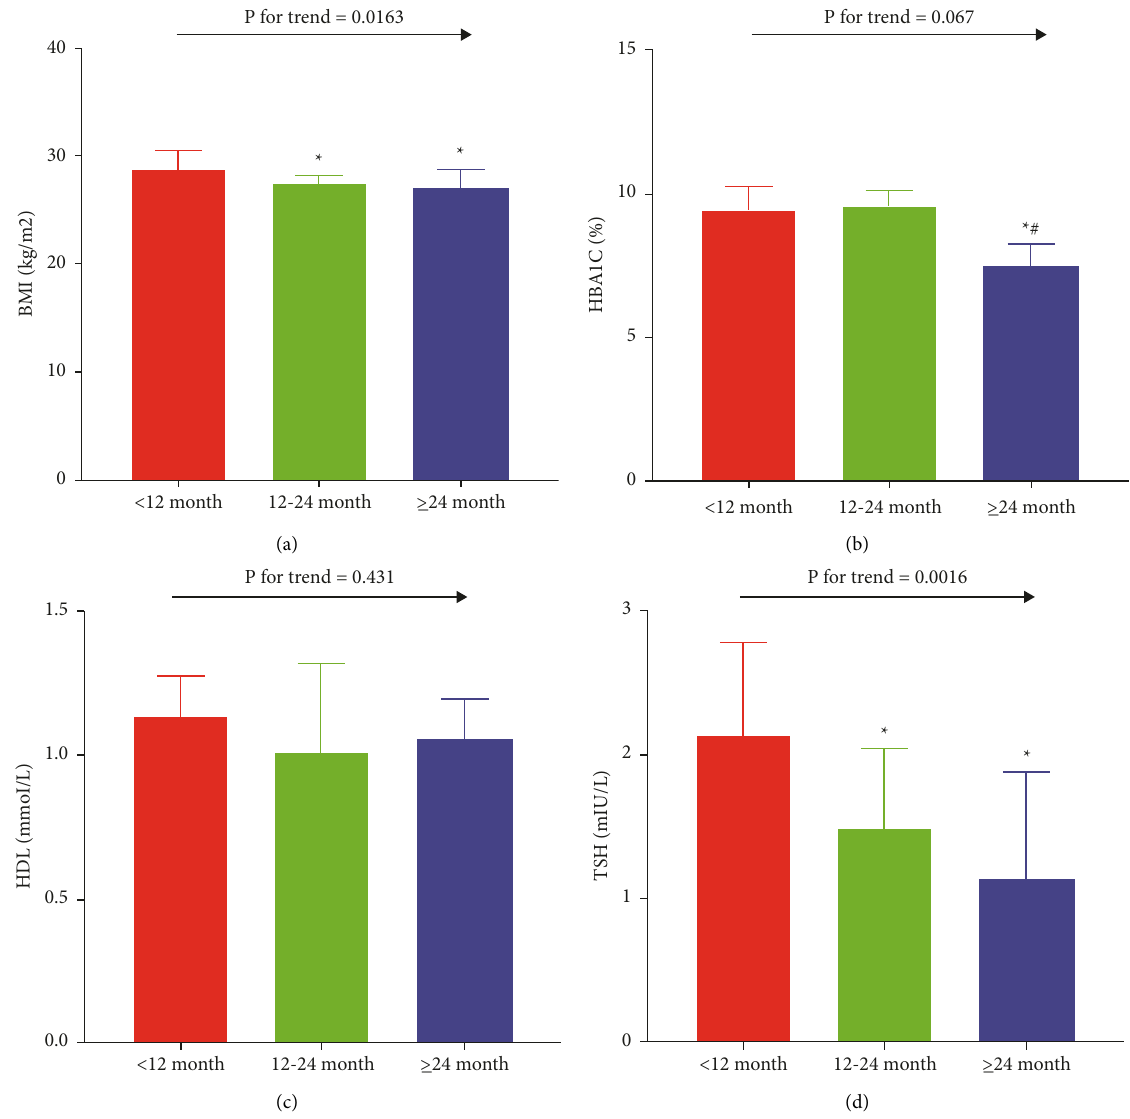
Figure 3: Subgroup analysis with stratification by usage period of liraglutide. Covariance analysis of (a) body mass index, (b) hemoglobin A1c, (c) high-density lipoprotein, and (d) thyroid-stimulating hormone (TSH). Values are expressed as the mean ± standard deviation. ∗ p < 0 . 05 vs. the < 12 months group; # p < 0.05 vs. the ≥ 12 and < 24 months